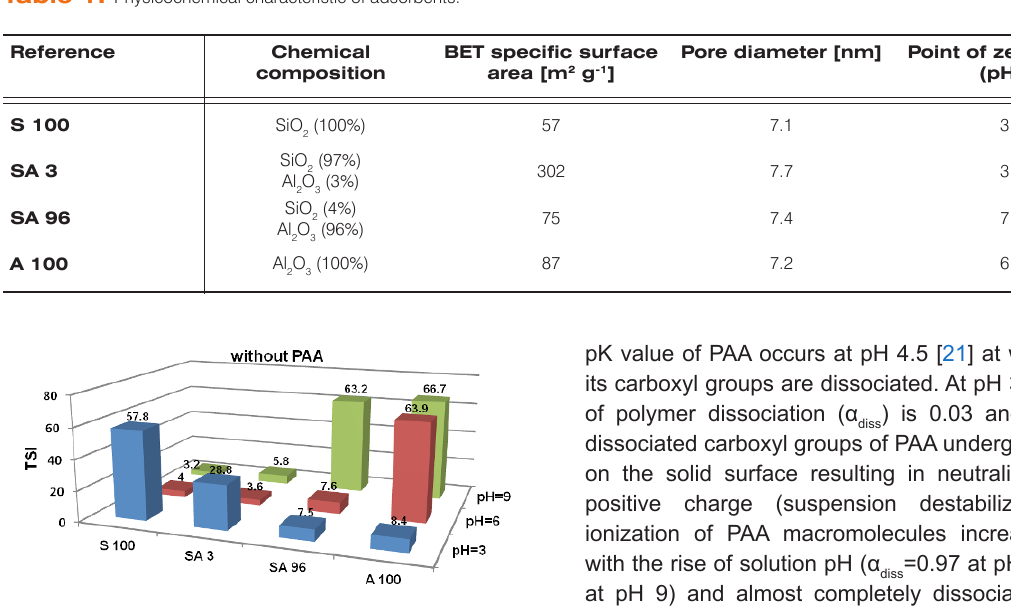
Table 1. Physicochemical characteristic of